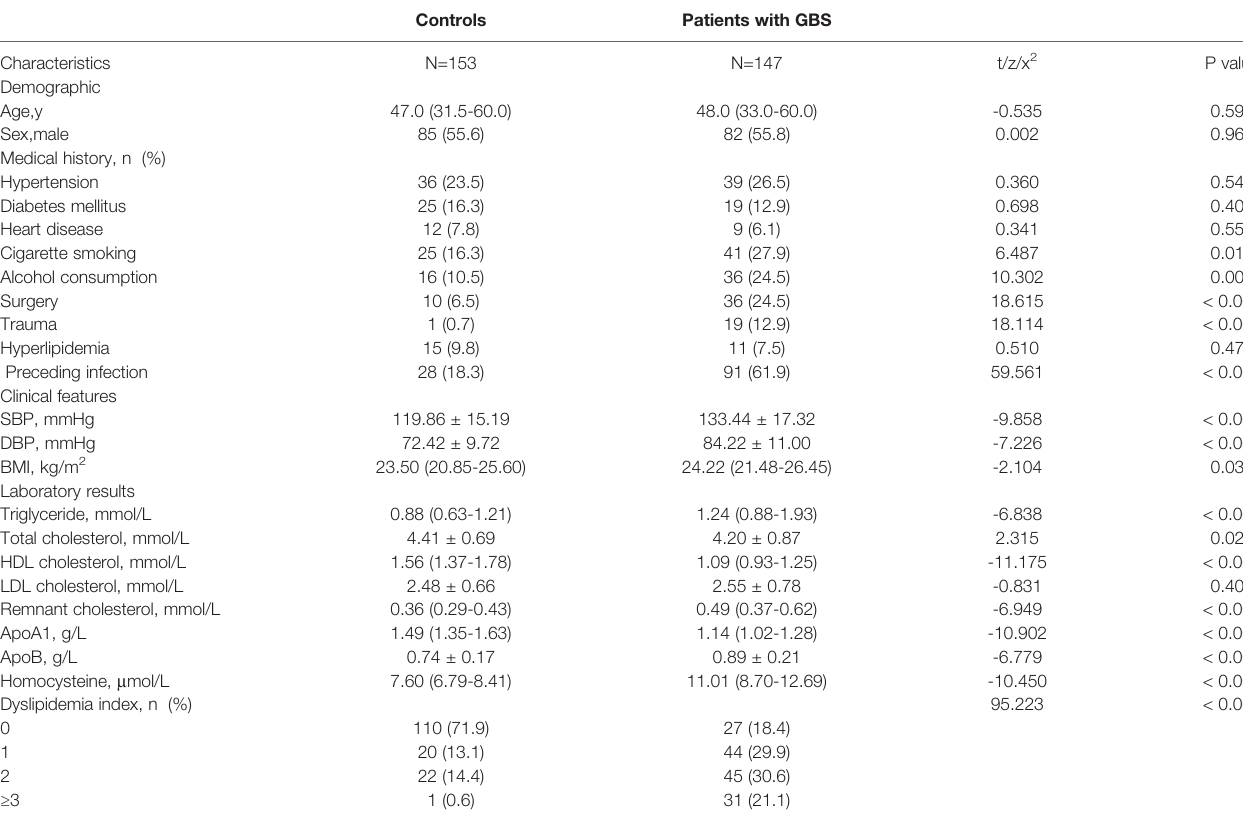
TABLE 1 | Clinical and Laboratory Characteristics in Patients With GBS and Healthy Controls .